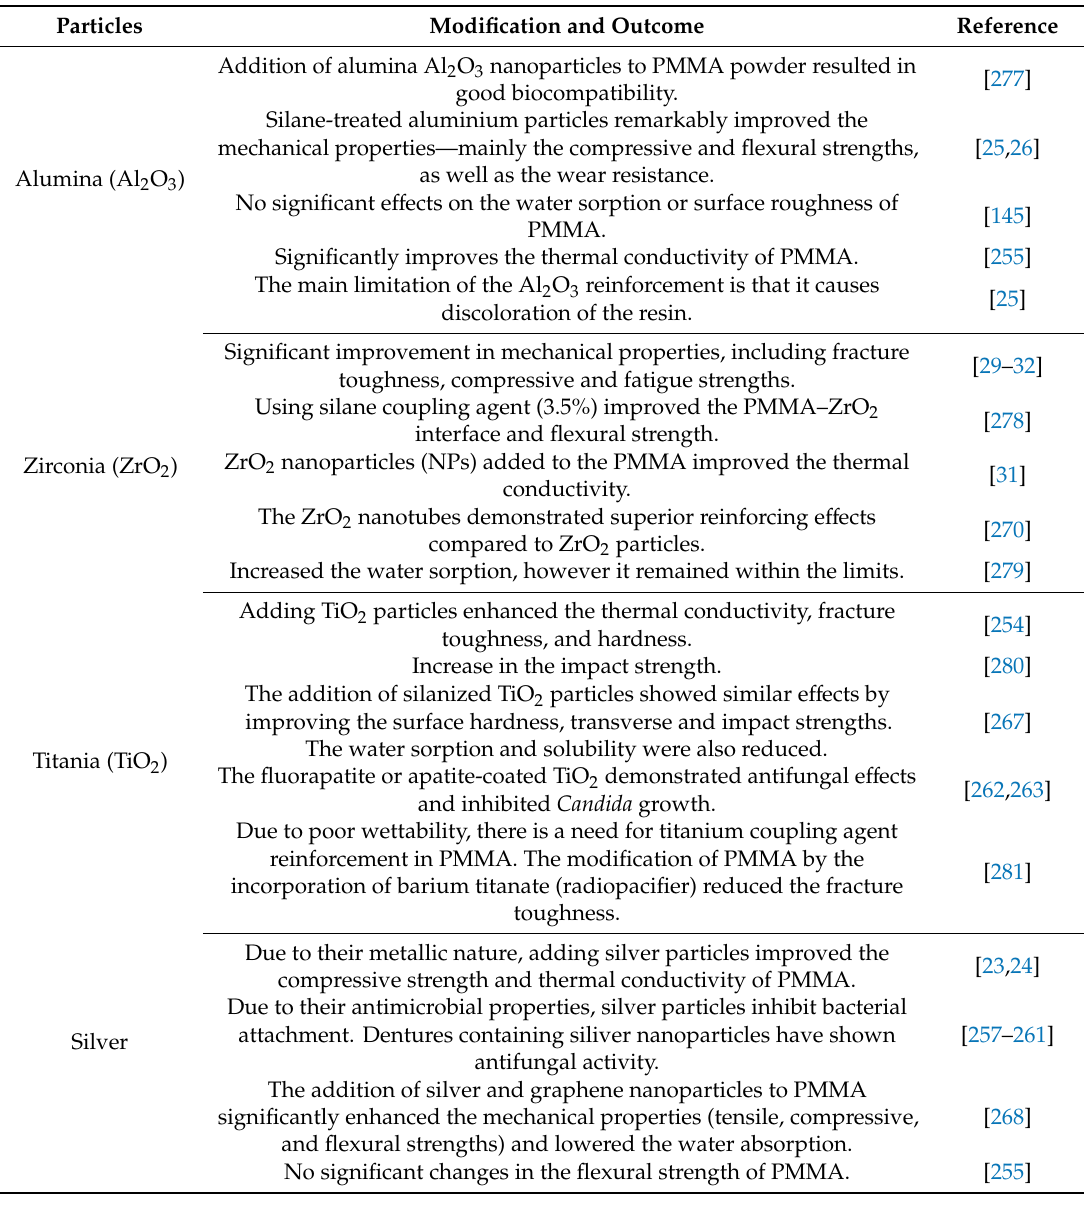
Table 7. Characteristics of various filler particles used for the mechanical reinforcement of